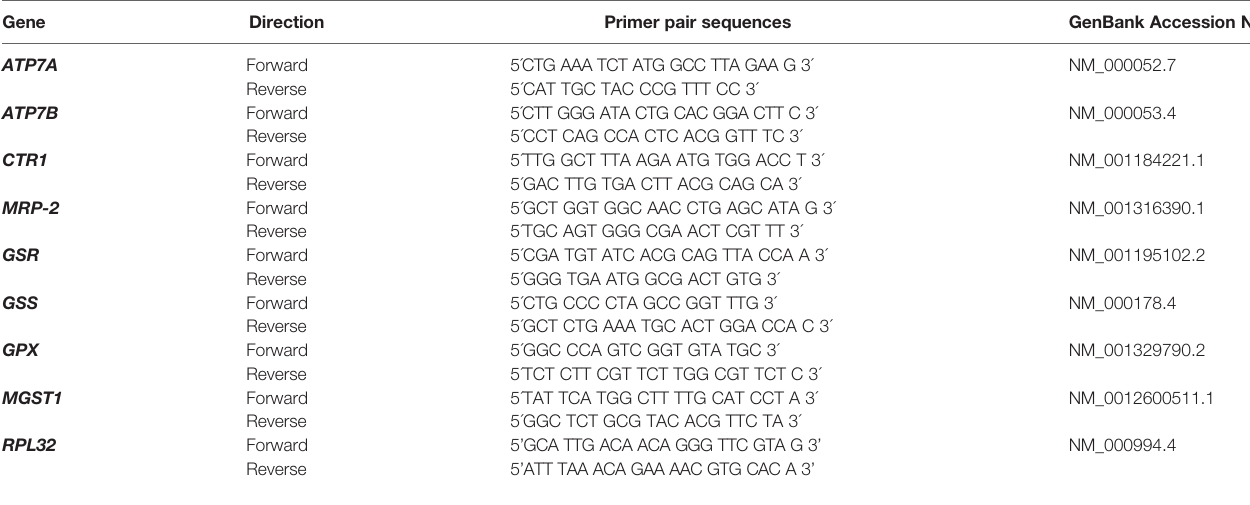
TABLE 1 | Primer pair